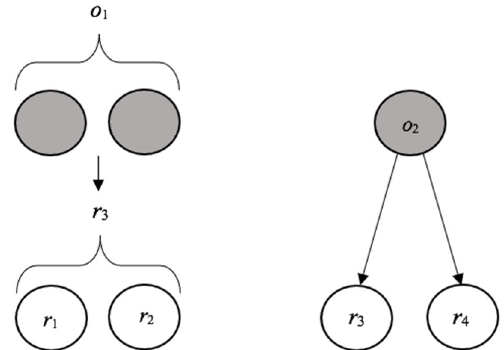
Figure 5. Multiple